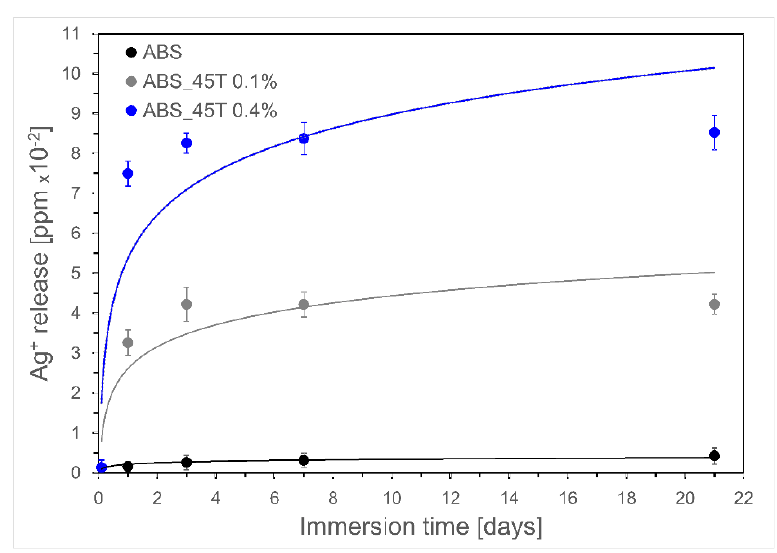
Figure 4. Kinetics of silver ions release during incubation in UHQ water up to 21 days.